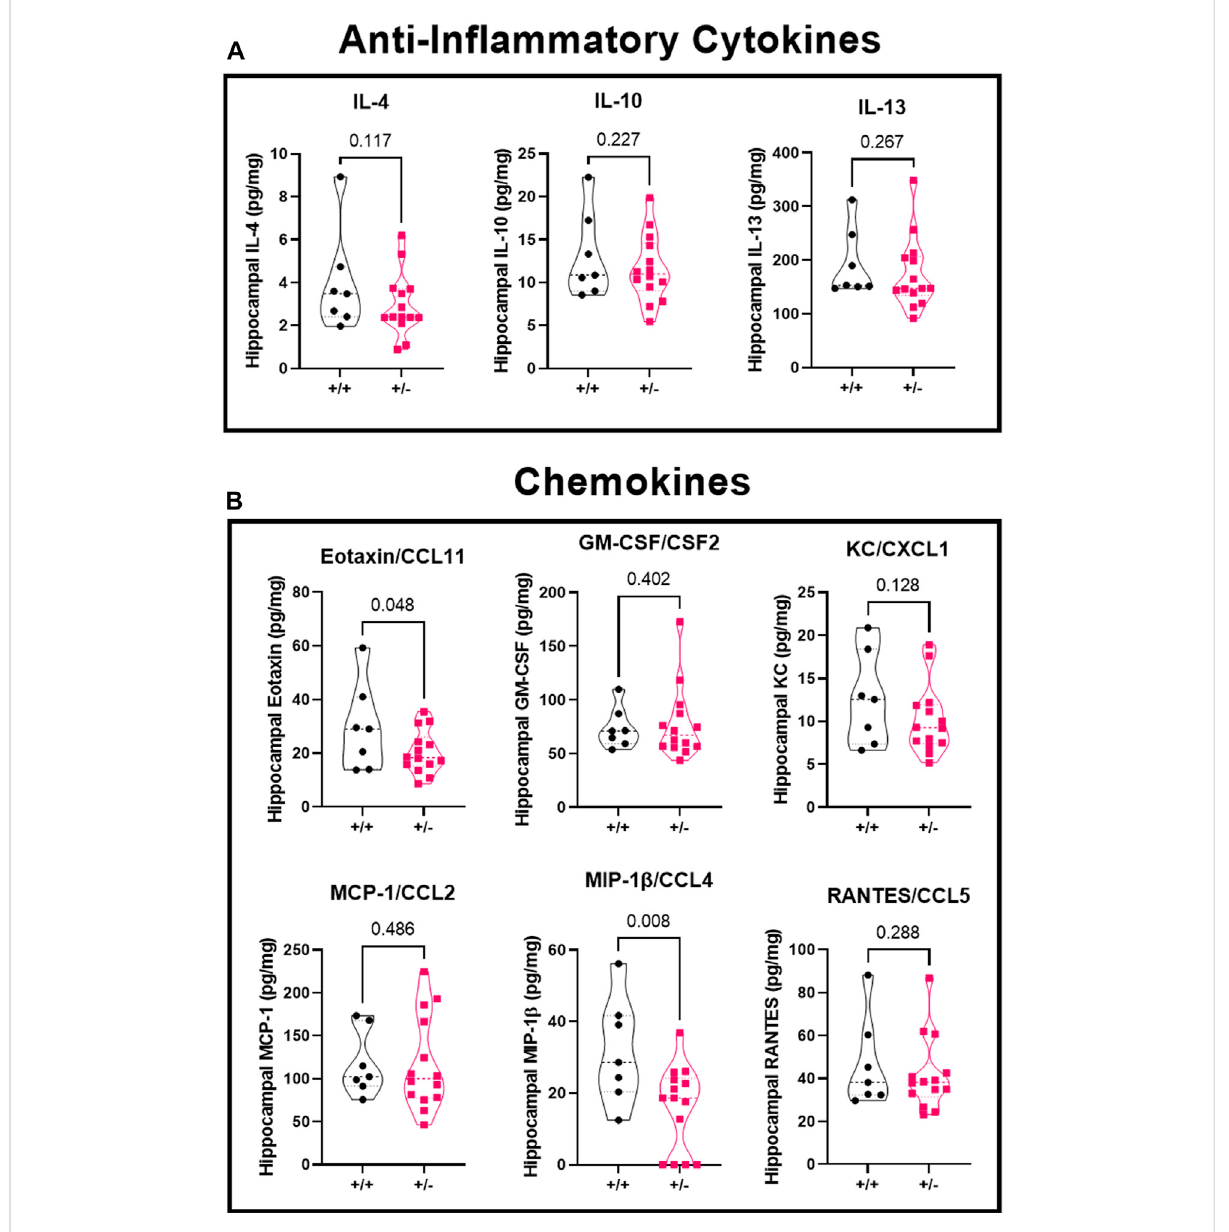
FIGURE 6 Changes in hippocampal anti-in fl ammatory cytokines and chemokines following seizures. Seizure exposure led to no differences in anti- in fl ammatorycytokines (A) ,IL-4,IL-10,orIL-13.Analysisofthechemokines (B) showsareductionineotaxin/CCL11,nodifferenceinGM-CSF,KC,or MCP-1, a decrease in MIP-1 β , and no change in RANTES levels at GD18.5 of pregnancy after 30 min of seizure exposure. N = 7 or 14 per genotype. Individual datapointsaredisplayed.ThickdashedlineisthemedianandthethindashedlinesarethequartilesSigni fi cancewascalculated using Mann-Whitney U